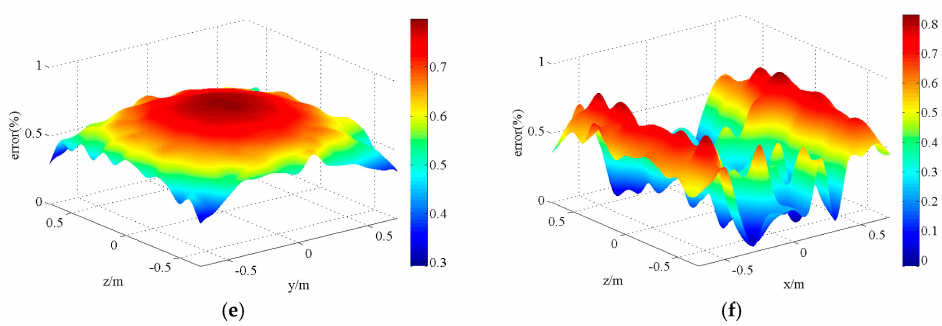
Figure 5. The relative errors between analytical value and finite element analysis value: ( a ) in the plane of x = 0 m; ( b ) in the plane of y ( z ) = 0 m; ( c ) in the plane of x = − 0.4 m; ( d ) in the plane of y ( z ) = − 0.4 m; ( e ) in the plane of x = − 0.8 m; and, ( f ) in the plane of y ( z ) = − 0.8